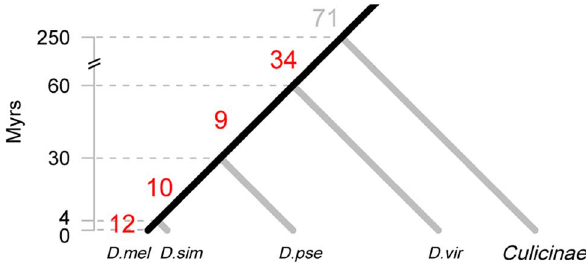
Figure 1. Origin of new miRNAs at different evolutionary periods. The divergence time of the phylogeny is based on the Drosophila 12 Genomes [27], Gaunt et al. [65] and Bolshakov et al. [66]. The number of highly expressed, canonical miRNAs that are inferred to originate in each time interval is given on the corresponding branch. Species abbreviations: D. mel , D. melanogaster ; D. sim , D. simulans ; D. pse , D. pseudoobscura ; D. vir , D. virilis . The 12 miRNAs of the last 4 Myrs are miR-979 and miR-4966 from the miR-972s cluster, miR-983-2 and miR-984 from the miR-982s cluster, miR-954, miR-956, miR-971, miR- 985, miR-990, miR-997, miR-1017 and miR-2279. The ten miRNAs emerged between 4 and 30 Myrs ago are miR-972, miR-978 and miR- 2499 from the miR-972s cluster, miR-303, miR-982 and miR-983-1 from the miR-982s cluster, miR-992 and miR-2498 from the miR-310s cluster, miR-1001 and